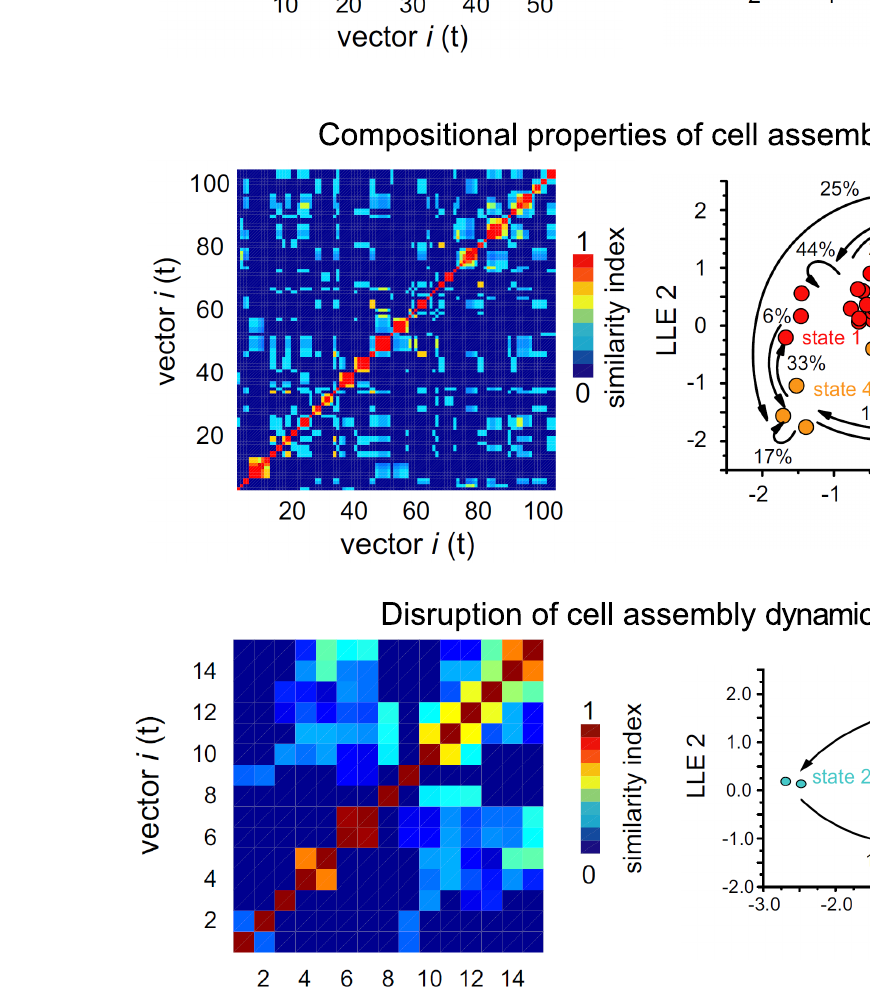
striatal neuronal pools. All these properties are characteristics of cell assemblies. Modified from Carrillo-Reid et al. (2009a). Middle: activation of the cholinergic system endows cell assemblies with compositional capabilities allowing the formation of complex sequences of activity from elemental patterns. Modified from Carrillo-Reid et al. (2009a). Bottom: blockade of GABA receptors engages the striatal A network in a dominant state. Note the drastic readjustment of cell assemblies from diverse cycles of activity with compositional properties to a fixed pattern that reduced the cell assembly diversity. Modified from Carrillo-Reid et al.